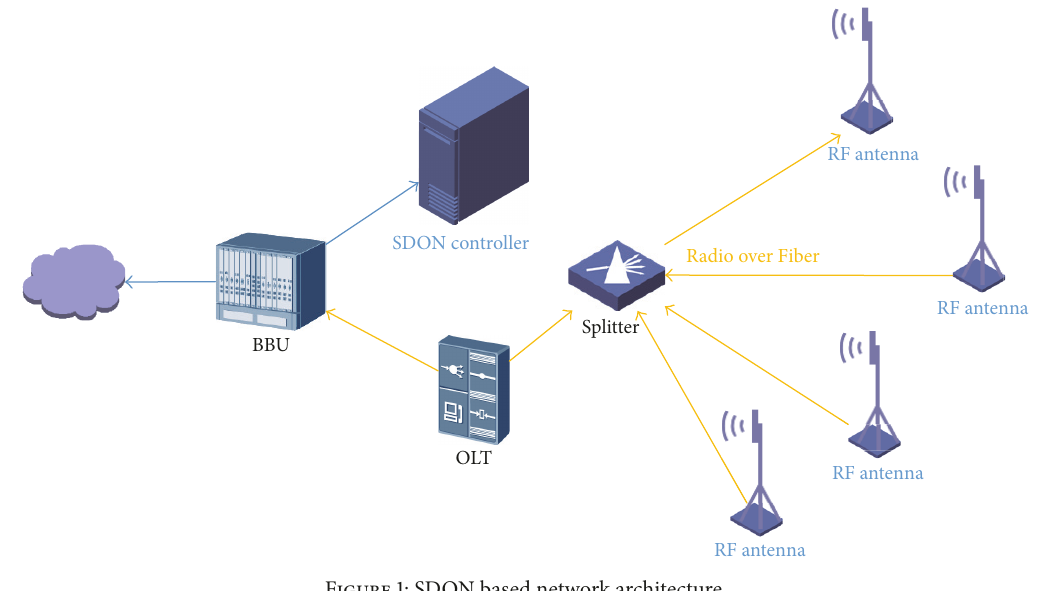
Figure 1: SDON based network architecture. Table 2: Uplink and downlink